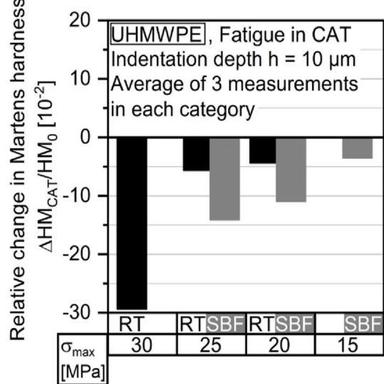
Change in Martens hardness ΔHMCAT after the mechanical loading due to constant amplitude tests (CAT) in relation to the initial condition HM0.